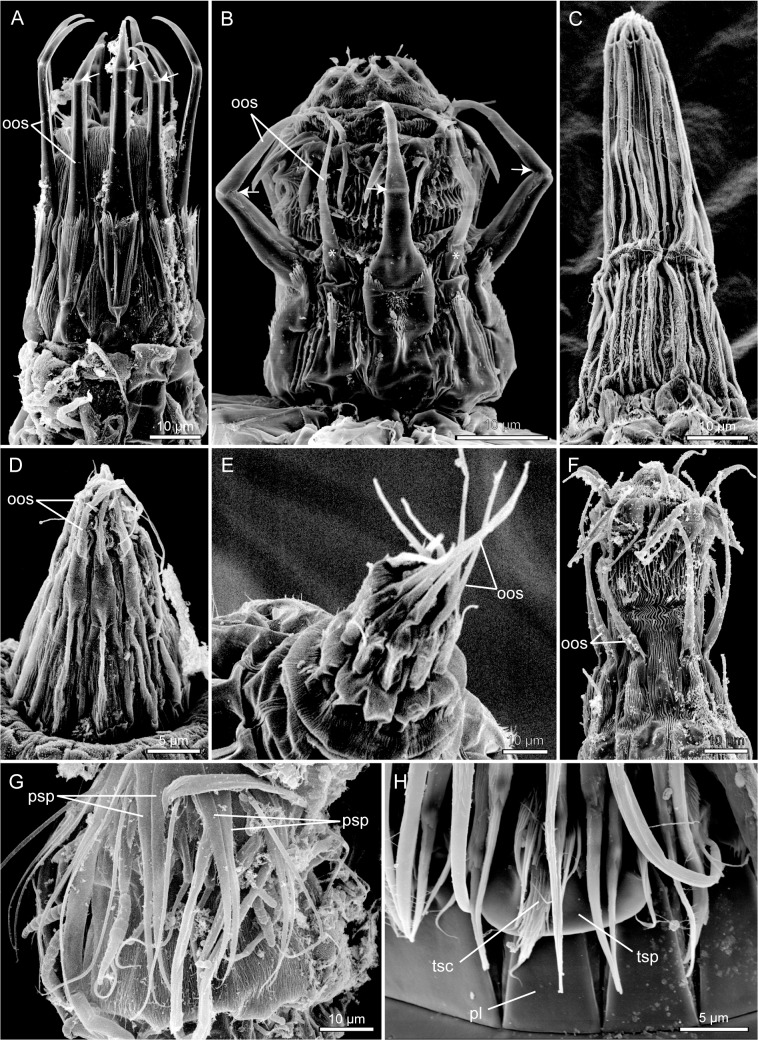
Scanning electron micrographs showing selected morphological character states for characters 1 to 6.A. Mouth cone of Wollunquaderes majkenae showing articulated outer oral styles of equal sizes (character 1, state 0; character 2, state 0). B. Mouth cone of Dracoderes abei, with articulated outer oral styles alternating in size between larger and smaller (marked with *) ones (character 1, state 1; character 2, state 0). C. Outer oral styles in Campyloderes cf. vanhöffeni, being either absent or completely fused with mouth cone (character 3, state 2). D. Mouth cone with partly fused outer oral styles of Condyloderes sp. 1 (character 3, state 1). E. Mouth cone with soft, non-articulated outer oral styles of Pycnophyes communis (character 2, state 1). F. Mouth cone with soft, non-articulated outer oral styles of Pycnophyes kielensis (character 2, state 1). G. Introvert of New Genus, showing basally bifurcated primary spinoscalids (character 4, state 1). H. Detail from neck of Echinoderes microaperturus, showing a trichoscalid attaching to its trichoscalid plate (character 6, state 1). Abbreviations: oos, outer oral styles; pl, placid; psp, primary spinoscalids; tsc, trichoscalid; tsp, trichoscalid plate. Arrows indicate articulations of outer oral style units.